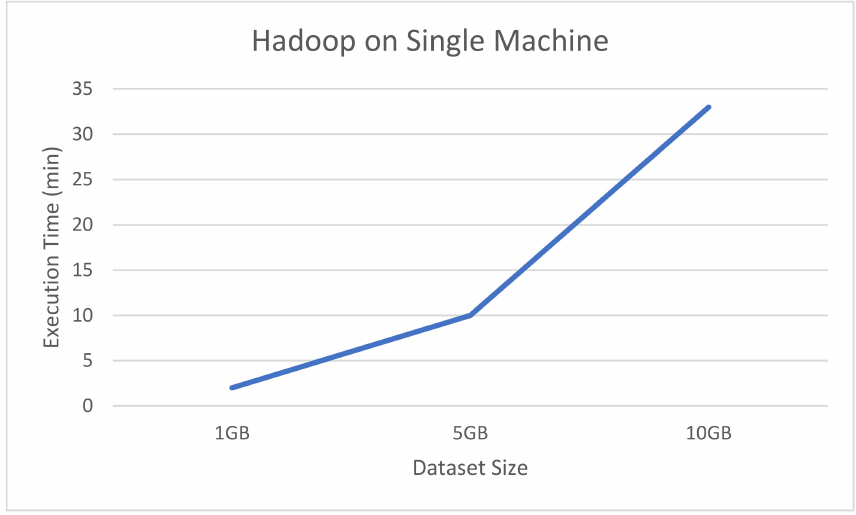
Figure 11. Execution time of Hadoop on a single machine.